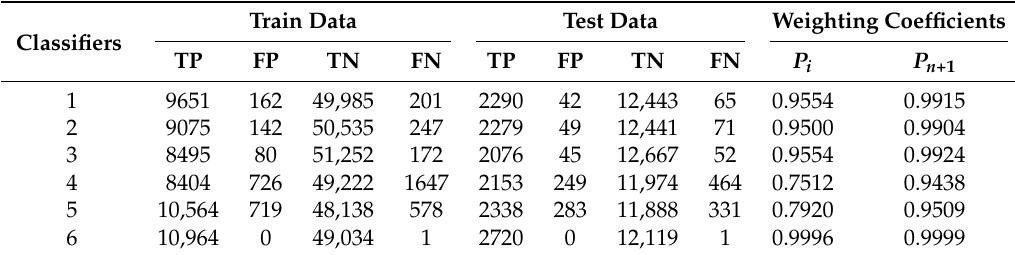
Table 2. Evaluation parameters and weighting coefficients of each